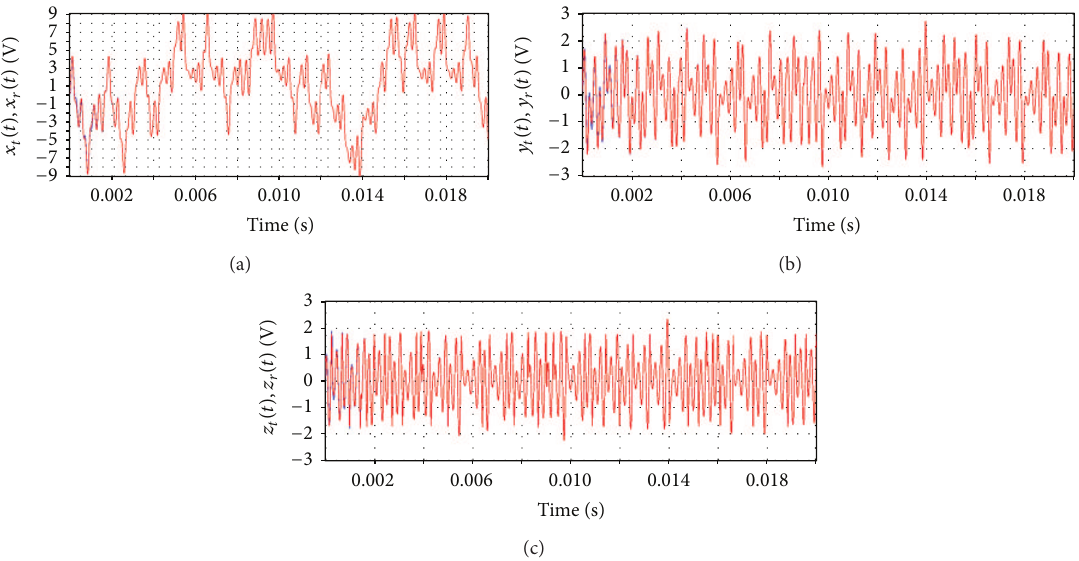
Figure 5: Time-domain chaotic waveforms for the transmitter (red line) and receiver (blue line) circuits with the synchronization circuit